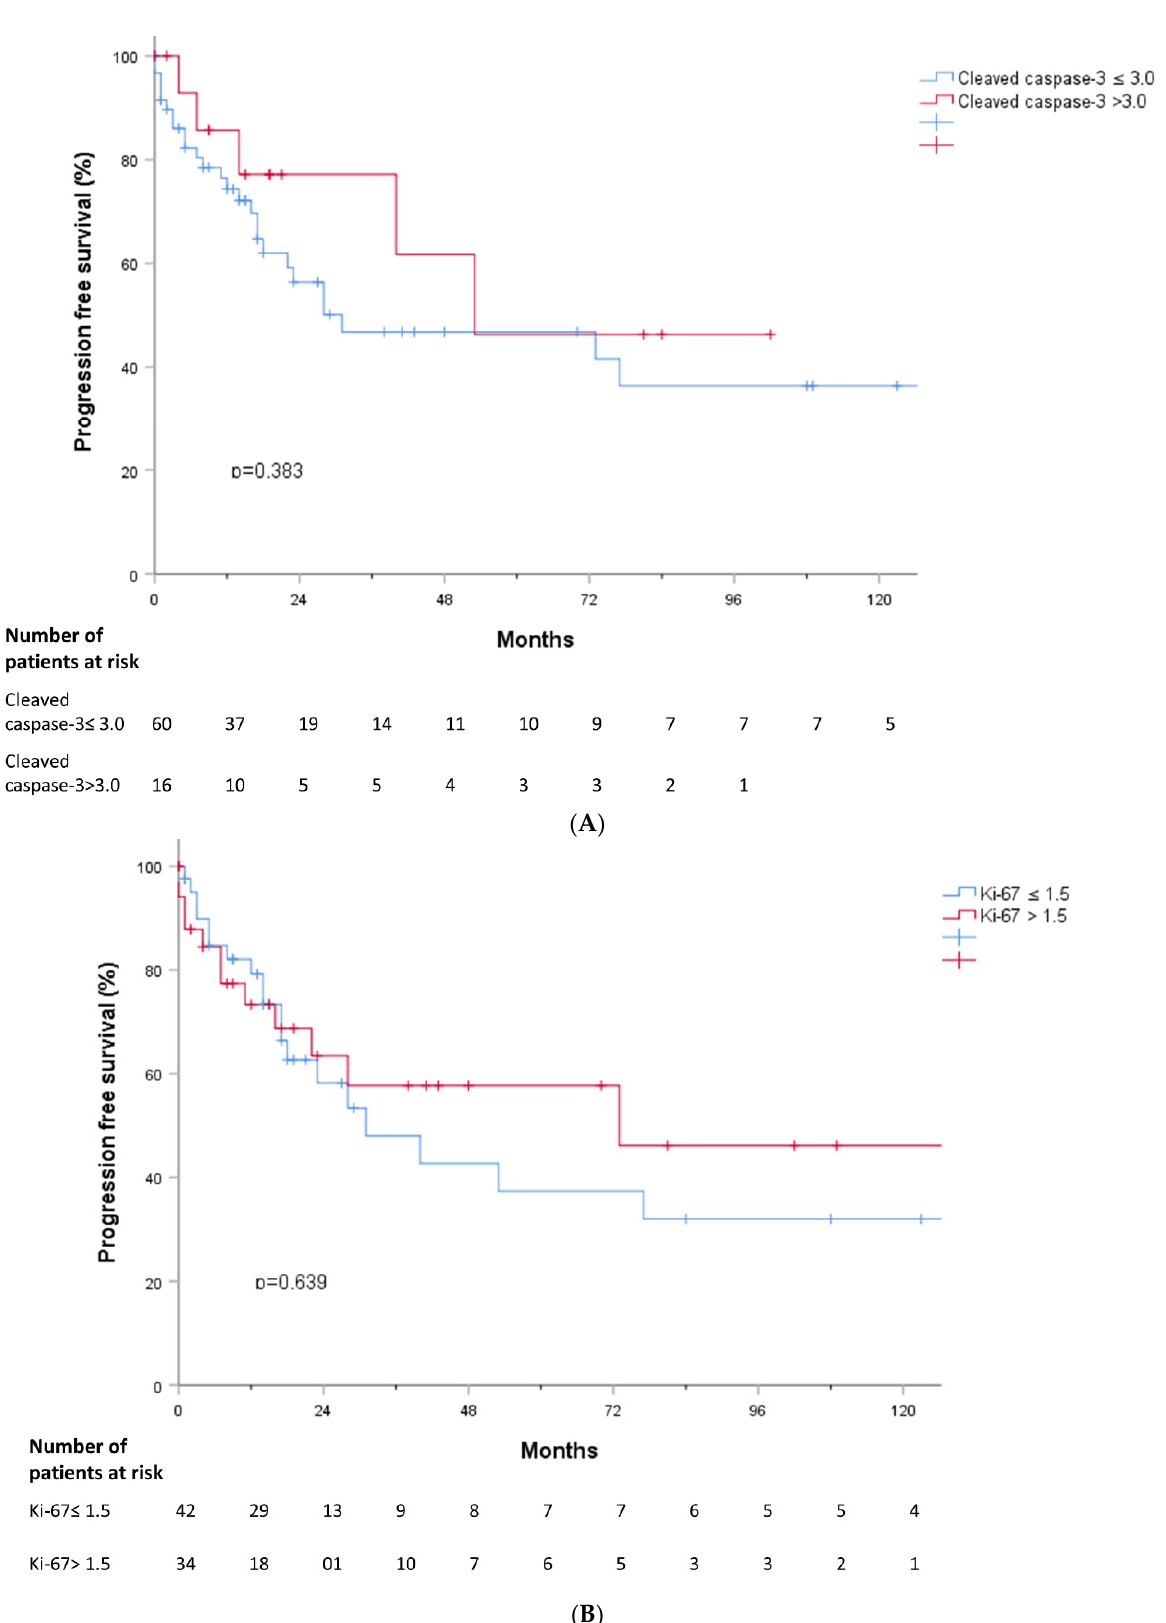
Figure 6. ( A ) Progression free survival according to cleaved caspase-3. ( B ) Progression free survival according to Ki-67.